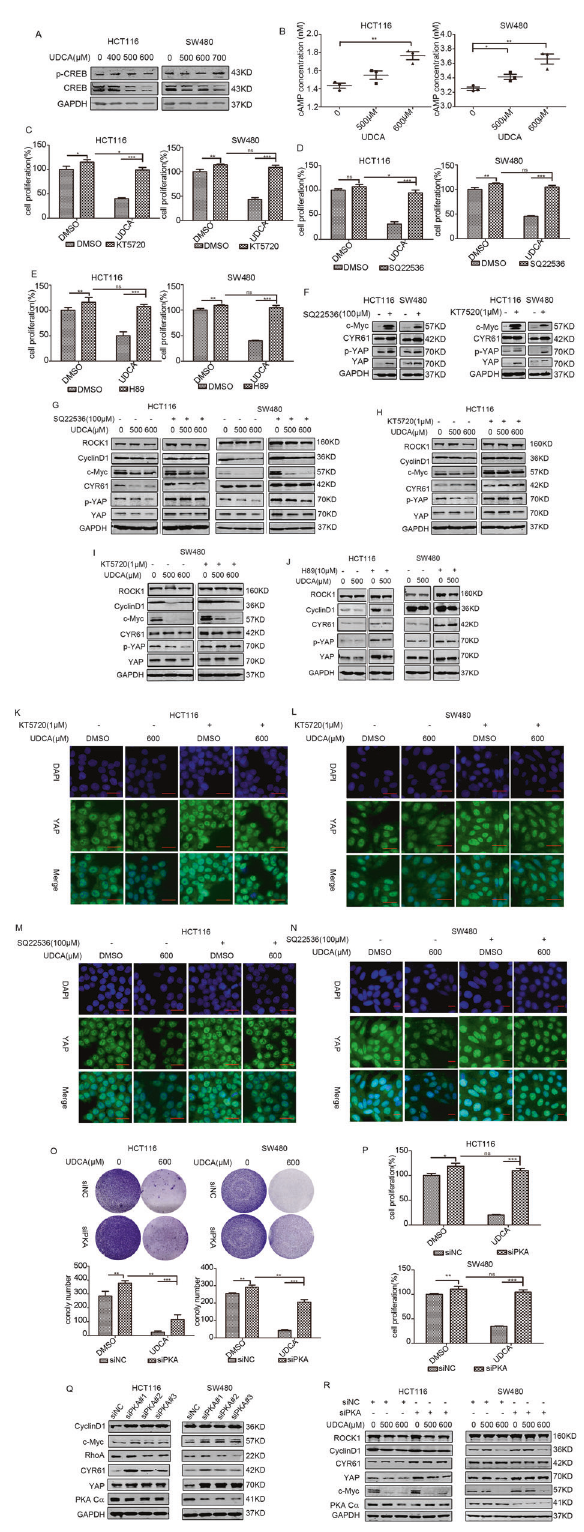
However, accumulating evidence indicates that YAP might promote tumor growth. Abnormal elevation of primary BAs has been found to promote liver tumorigenesis. The primary BAs, CDCA, or CA, act as upstream regulators of YAP via a pathway dependent on IQGAP1 activation. Patients with diverse biliary